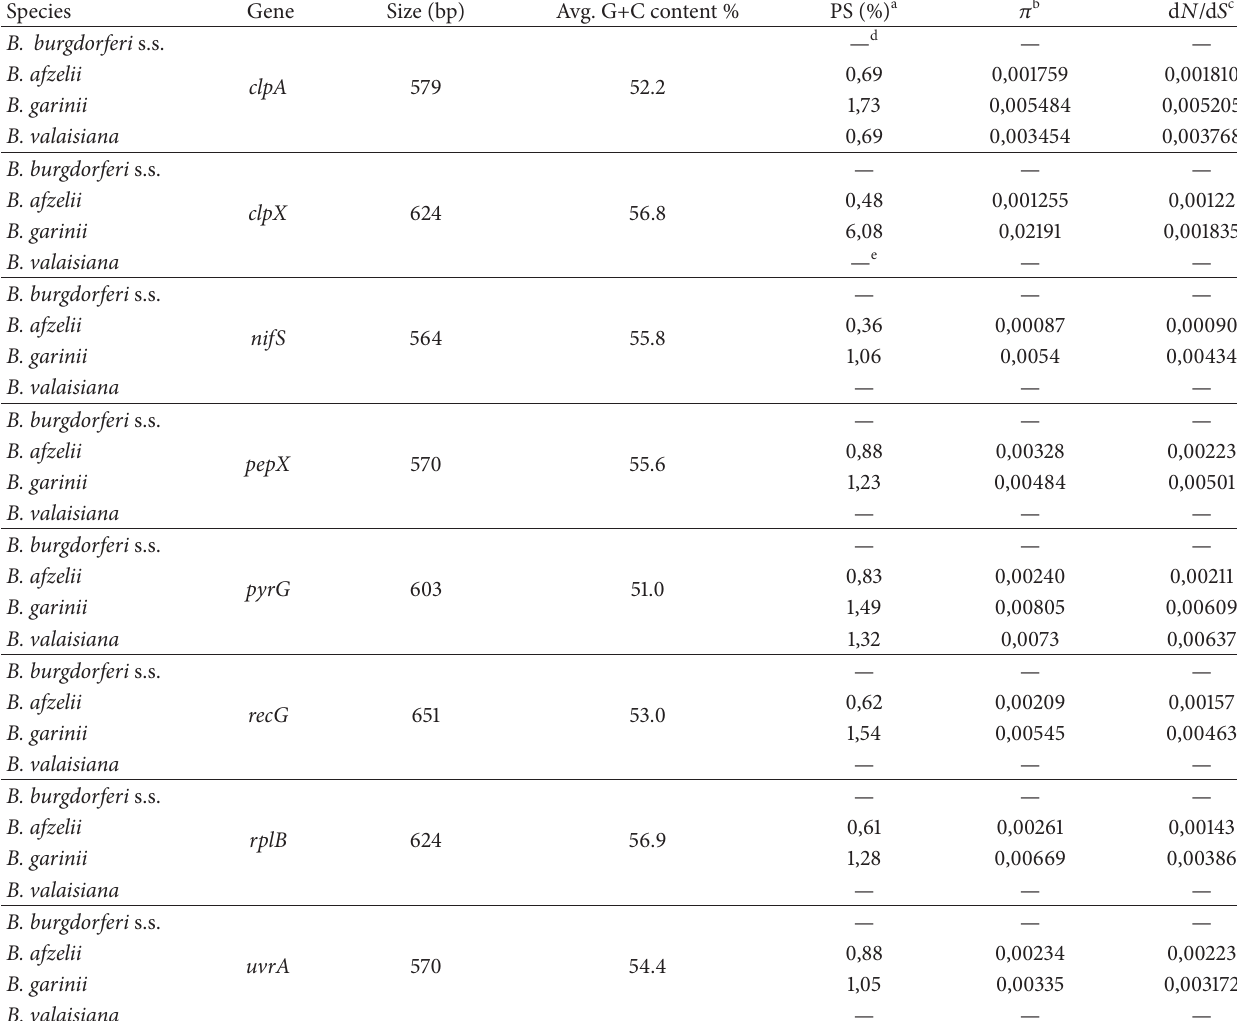
Table 2: Characteristics of each housekeeping